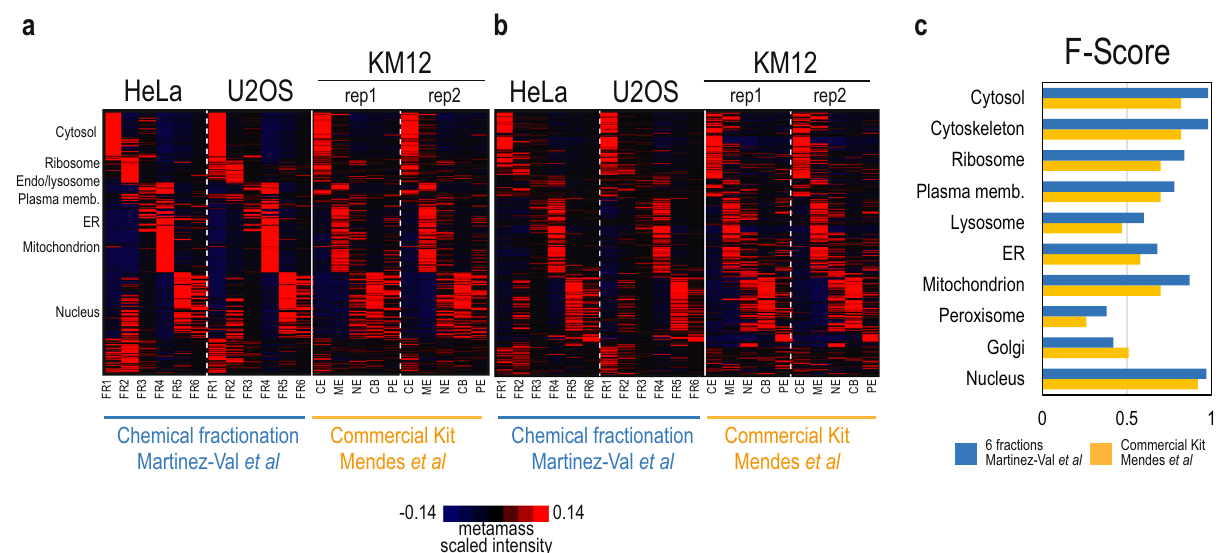
Fig. 3 Comparative analysis of subcellular fractionation protocols based on chemical reagents using Metamass. a – b Heatmaps showing protein distribution across fractions obtained from HeLa and U2OS using the present subcellular fractionation protocol and KM12 using the commercial kit (Pierce) employed in Mendes et al. 29 . Proteins were classi fi ed and sorted using the Excel-based analysis tool MetaMass (Supplementary Data 4). In ( a ) proteins are clustered based on the data from HeLa and U2OS fractionation in the present study. In ( b ) proteins are clustered based on Mendes et al data. Heatmaps were obtained after normalizing gene distribution and center samples by mean in Cluster 3.0, and plotted in TreeView. CE Cytoplasmic Extract, ME Membrane Extract, NE Nuclear Extract, CB Chromatin-Bound, PE Pellet Extract, ER Endoplasmic Reticulum. c F-score barplot for the protein assignment to organelles in the present study (blue) and in Mendes et al